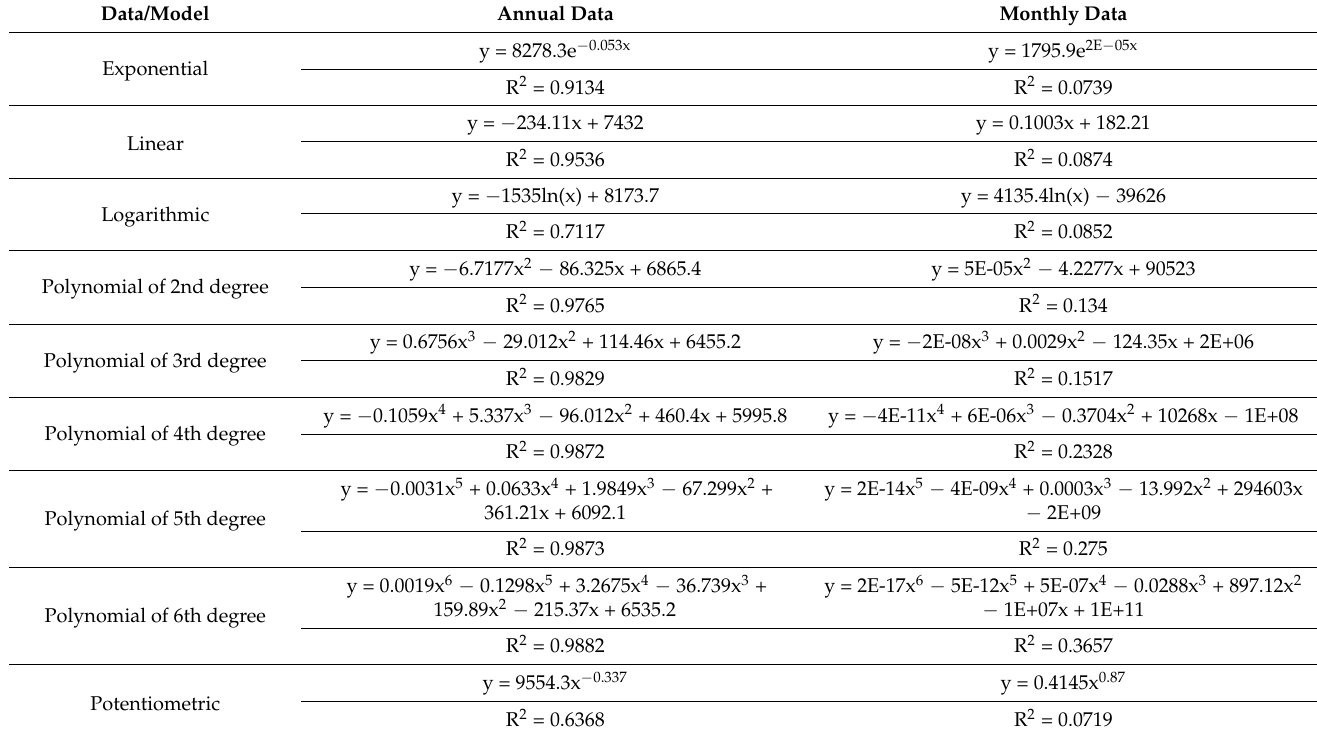
Table A12. Trend models for the Silesian province.